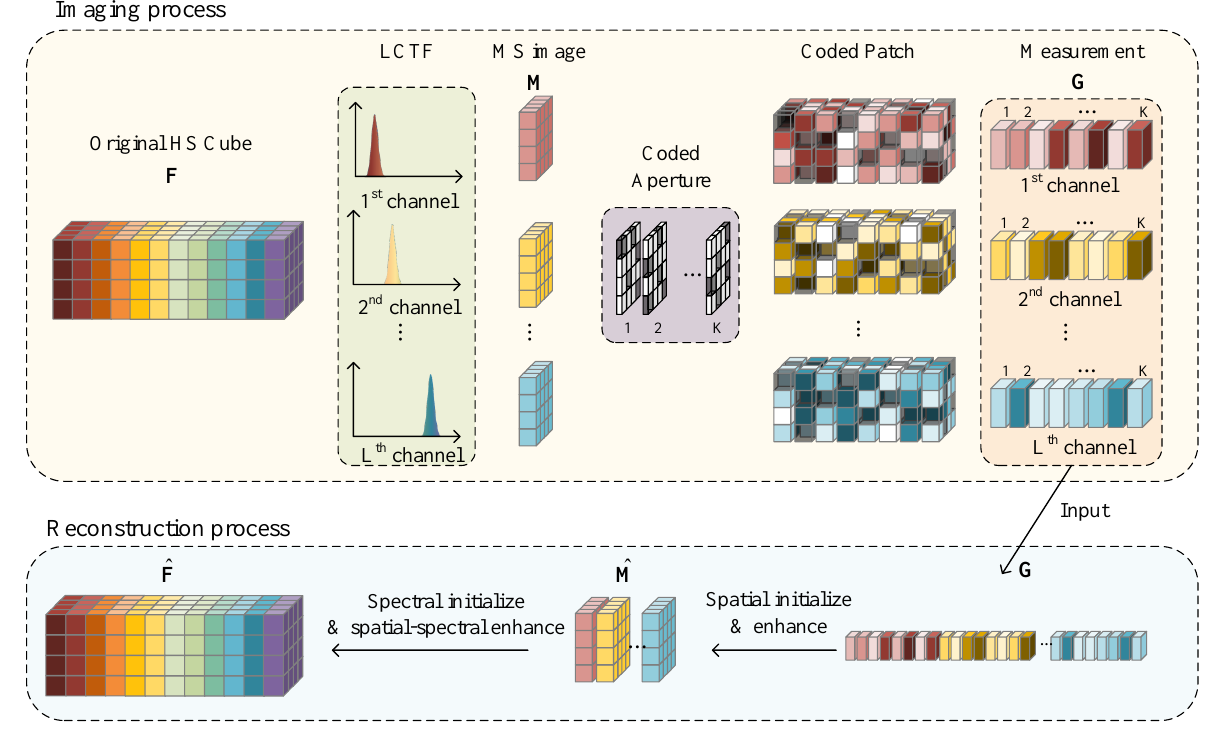
Figure 2. The imaging model of the CATF spectral imager and the reconstruction process (diagram of one pixel on the detector). The upper part of the figure describes the imaging process of the CATF spectral imager. The original hyperspectral (HS) cube is first filtered by LCTF with L channels to generate multispectral (MS) image (without loss of spatial resolution). It is then spatially modulated by DMD with K coded apertures. Finally, L × K measurements are obtained on the detector. The reconstruction process is in the lower part of the figure, backtracking the imaging process step by step. The detector measurements are used as the input, then the MS image with the same spatial resolution as DMD is produced via spatial initialization and enhancement. The reconstructed HS cube is finally acquired after spectral initialization and spatial–spectral information